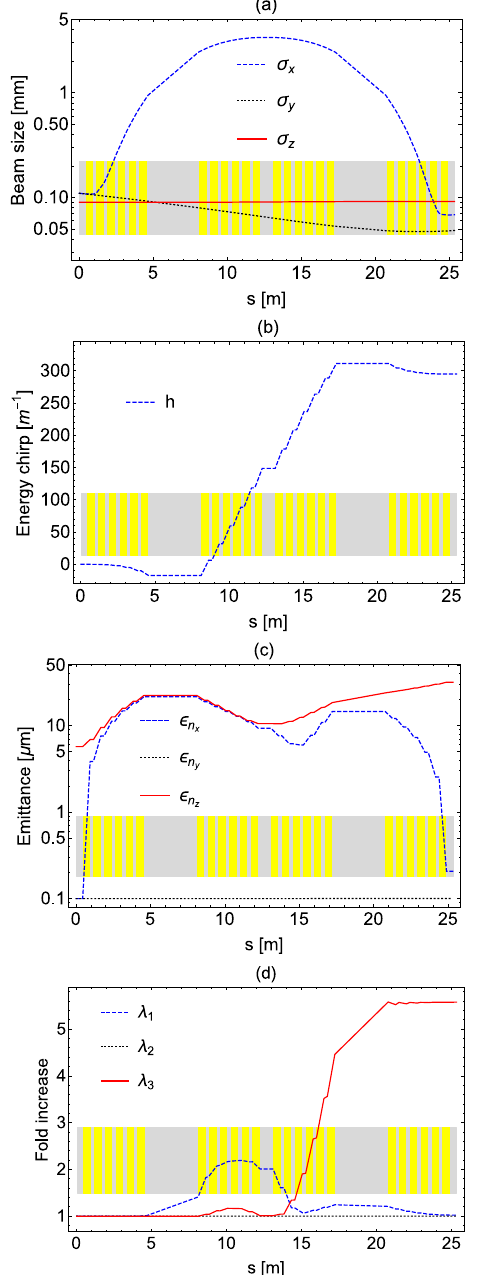
FIG. 3. The rms beam sizes (a), energy chirp (b), emittances (c), and increase in eigenemittances (d) along the beam line for the unoptimized Twiss parameters β x ¼ β y ¼ 59 m and α ¼ α ¼ 2 . 1 . Each 13-cell cavity is marked as a yellow x y rectangle representing its actual geometric length and position along the beam line.